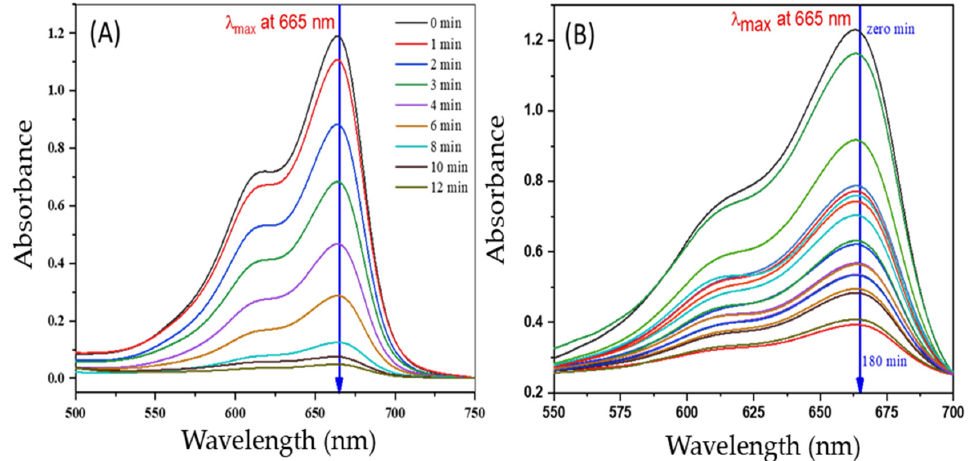
Figure 9. UV-Vis absorbance spectra of ( A ) Ag NPs in a mixture liquor containing NaBH 4 and MB, and ( B ) the same mixture without Ag NPs at different reaction times.